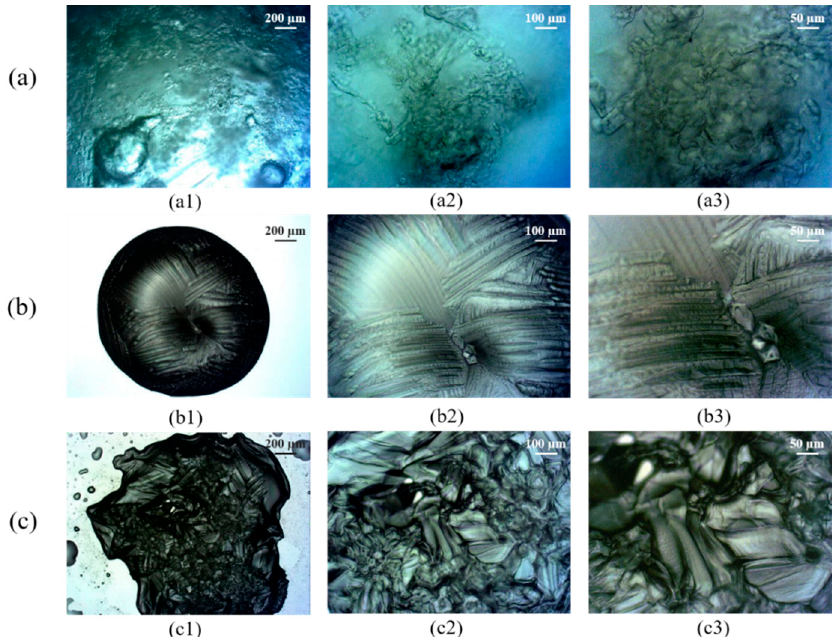
Figure 3. Crystal morphologies of ( a ) R141b; ( b ) TME, and ( c ) TBAB/TBAC hydrates at 5 °C and 0.1 MP, for scales of 200 (1), 100 (2), and (3) 50 μ m.